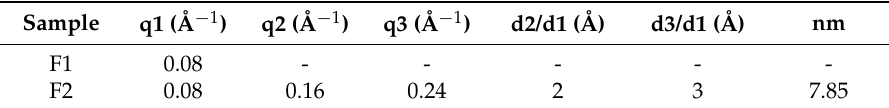
Table 1. Calculated d values for formulations. Peak positions of scattering power of small-angle X-ray scattering (SAXS) curves and their respective correlation distances (d) and assignments for phase classification (d1/d2 and d1/d3).